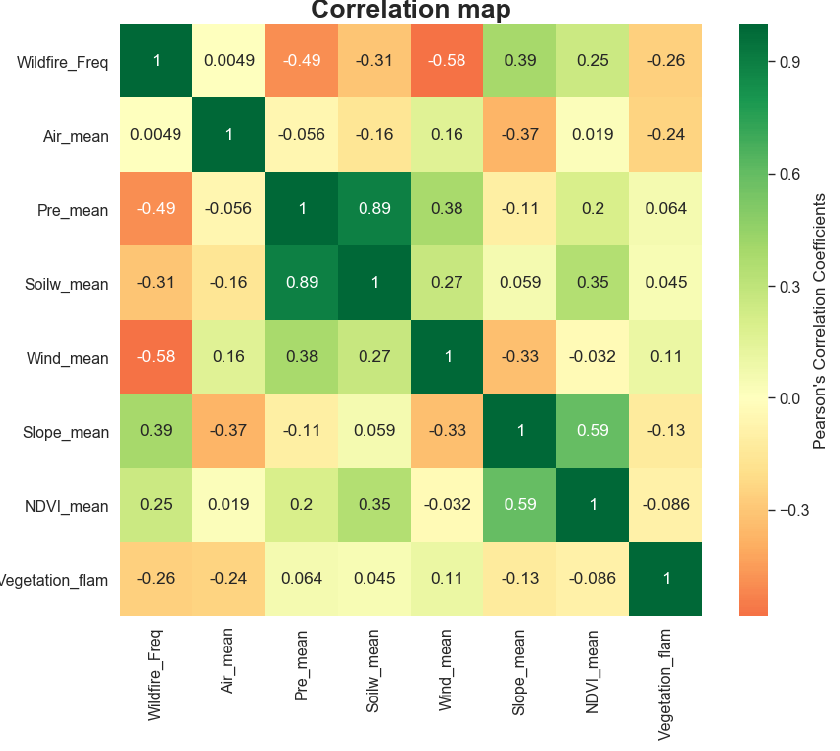
Figure 8. Pearson correlation coefficients of seven categories of influencing factors on the bushfire annual frequency.